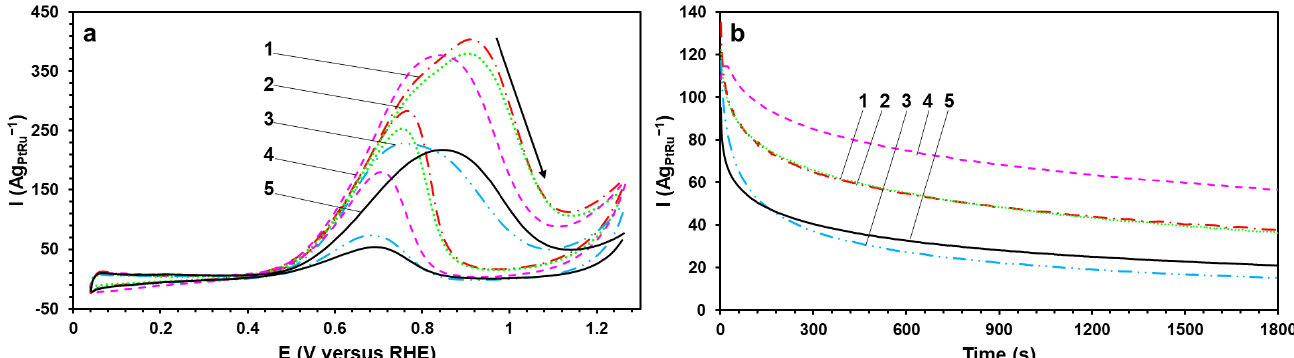
Figure 5. ( a ) The cyclic voltammograms of the PtRu/C catalysts. The potential sweep rate is 20 mVs −1 . The electrolyte is 0.5 М CH 3 OH + 0.1 М HClO 4 saturated with argon at the atmospheric pressure. ( b ) The chronoamperograms of the methanol electrooxidation for the PtRu/C catalysts at the potential of 0.6 V. 1 — BH; 2 — BHC; 3 — BHA; 4 — P; 5 — PtRu-AA.